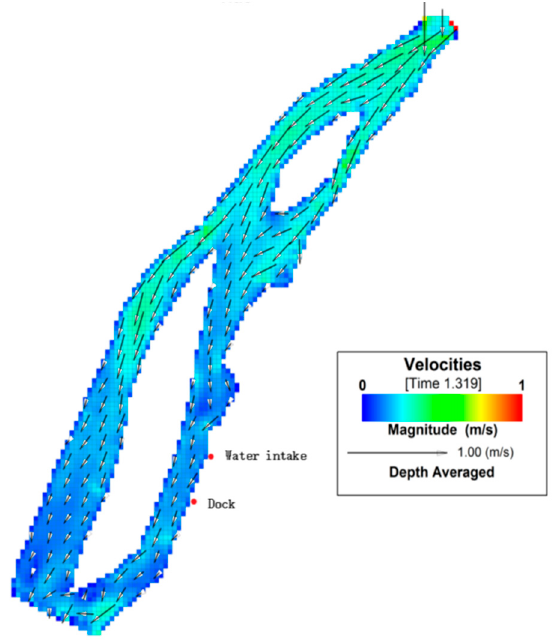
Figure 2. The distribution of the flow field of the calculation area at the time of rise and the emergency.